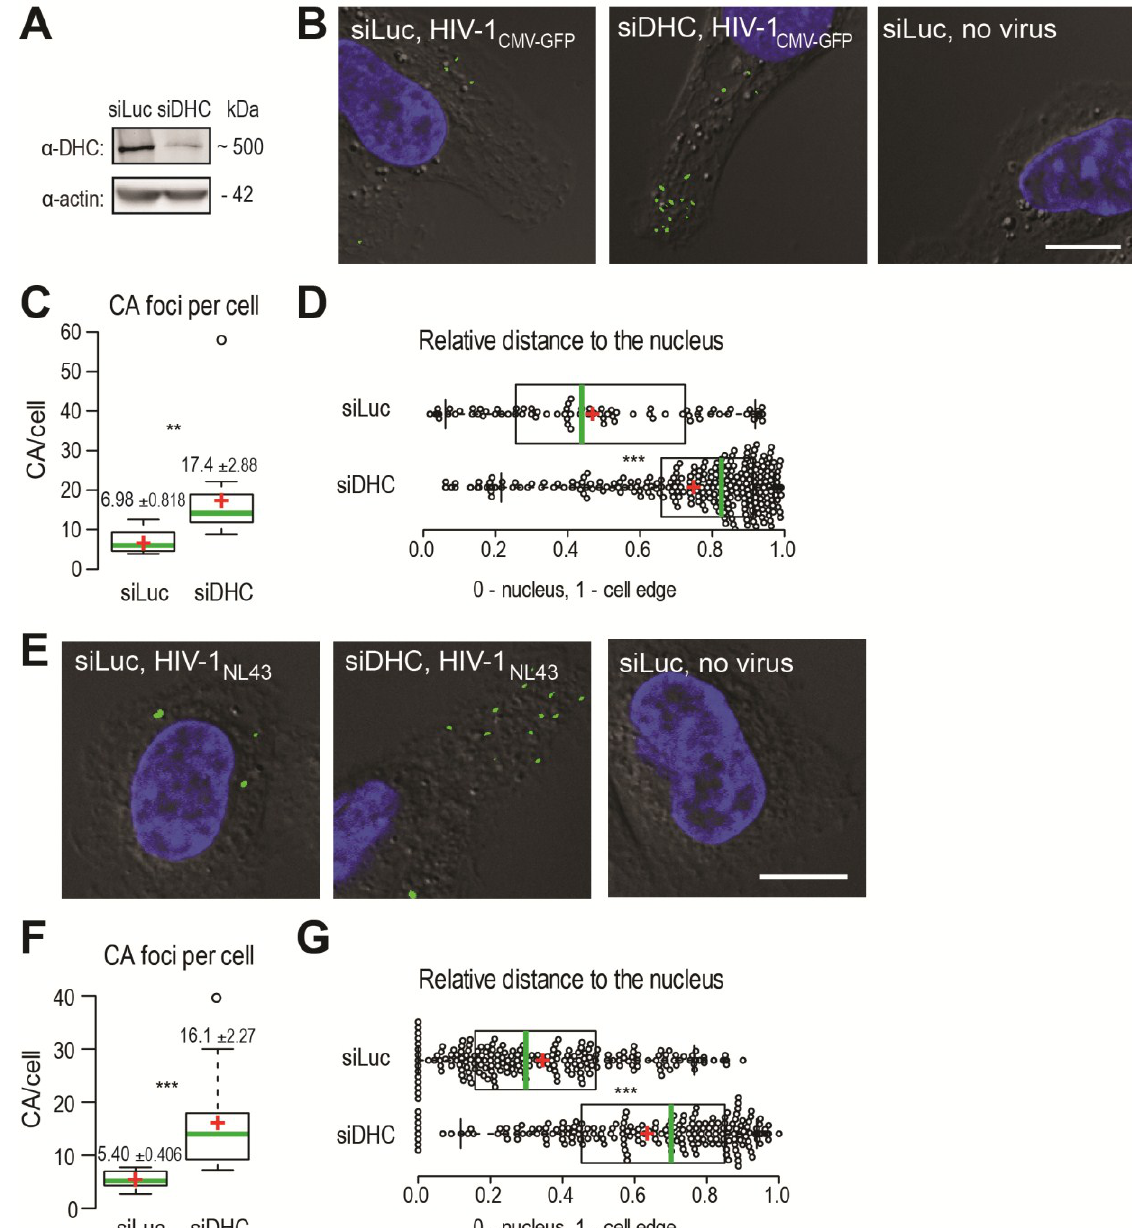
Figure 1. Dynein heavy chain (DHC) depletion causes the accumulation of HIV-1 CA cores in infected cells and alters their subcellular distribution. ( A ) HeLa cells were transfected with siRNAs targeting either dynein heavy chain (siDHC) or luciferase